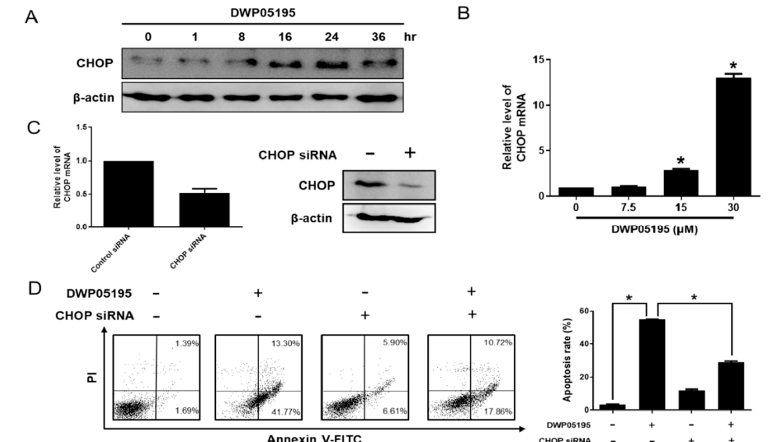
Figure 3. Involvement of C/EBP homologous protein (CHOP) in DWP05195-induced apoptosis. ( A